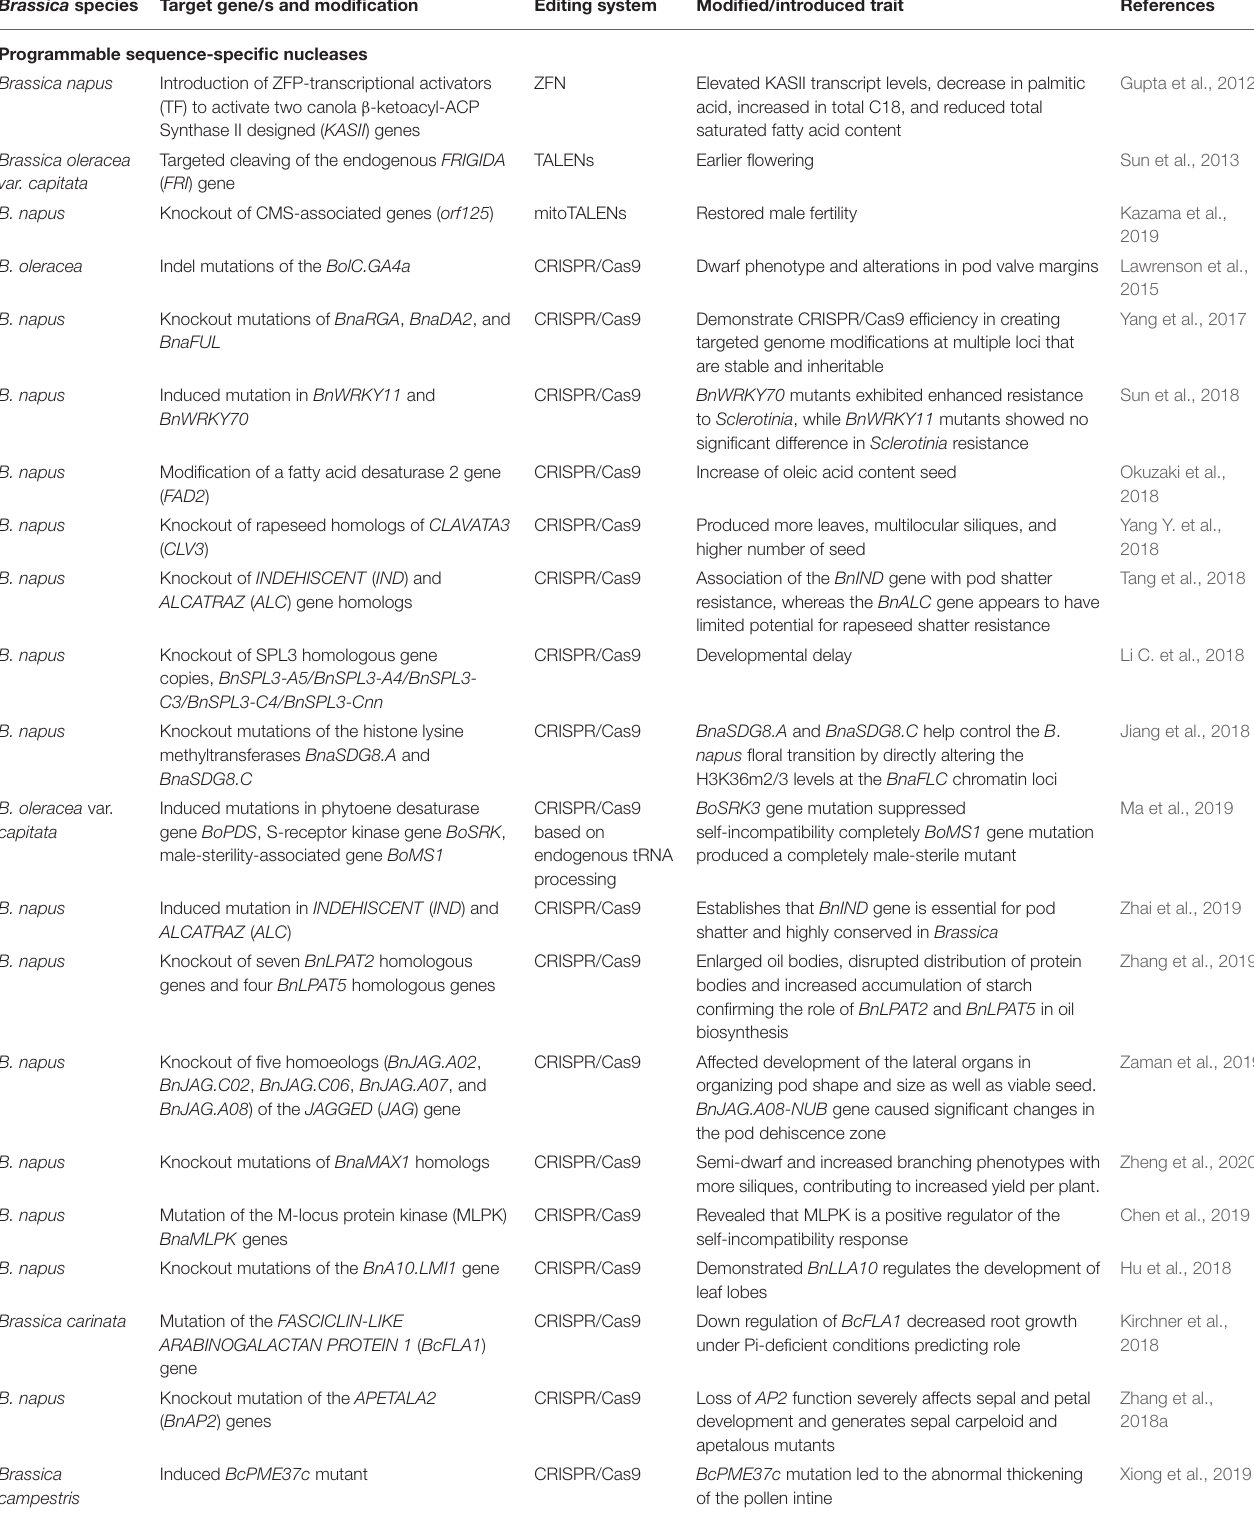
TABLE 5 | Application of programmable sequence-specific nucleases and targeted base editing tools in genome editing of Brassica